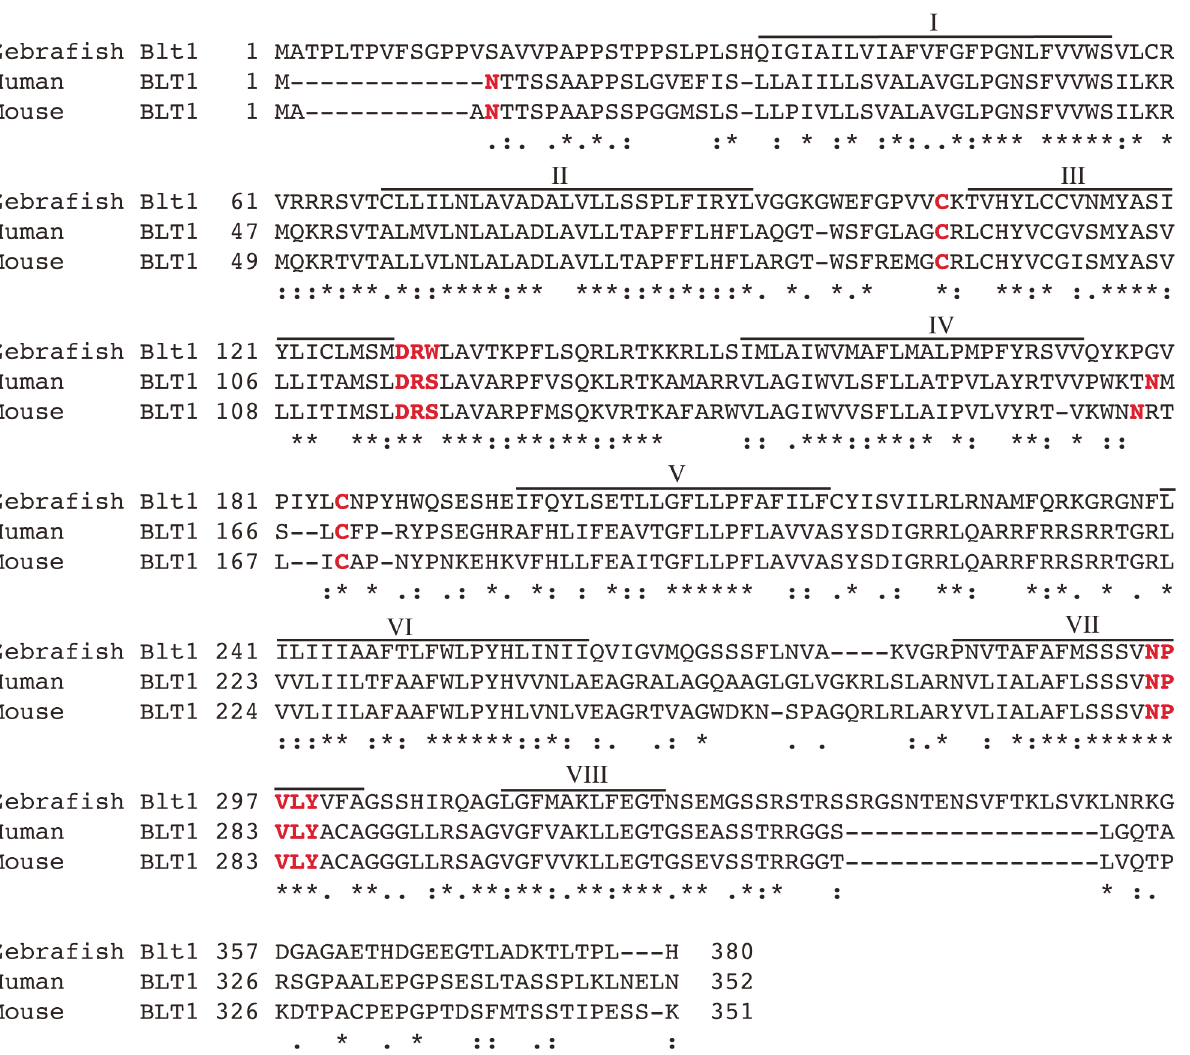
Fig 1. Sequence alignment of zebrafish Blt1 with human and mouse BLT1. The amino acid sequences of zebrafish Blt1 and human and mouse BLT1 were aligned using MAFFT (http://www.ebi.ac.uk/Tools/msa/mafft/). Identical residues are indicated with asterisks ( * ), highly conserved residues with colons (:), and semi-conserved residues with periods (.). The predicted glycosylated aspartate, the predicted cysteine residues that form disulfide bonds, and the DRY and N/DPxxY motifs are indicated in red characters. Putative helical domains that form helix I to helix VIII are indicated above the aligned sequences. The sequence of zebrafish Blt1 is available from EMBL/GenBank/DDBJ under accession no. LC009449.